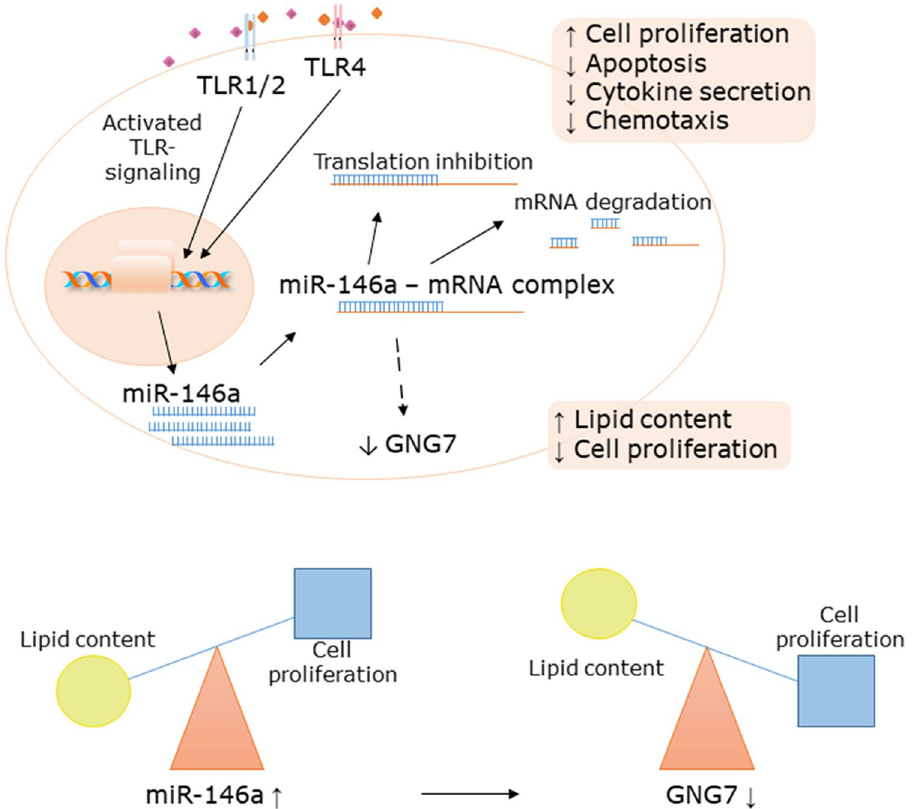
Figure 6. miR-146a links TLR-induced inflammation with cell proliferation and indirectly affects the lipid content of sebocytes via GNG7 . Our data showed that in response to TLR1/2 and -4 activation the expression of miR-146a, a microRNA leading to the degradation of its target mRNAs, is abundantly induced in sebocytes. The increased levels of miR-146a, observed also in acne samples, may have a negative regulatory effect on cytokine secretion and chemotaxis, induce cell proliferation and decrease apoptosis, while the parallel down-regulation of GNG7 , may shift the balance from proliferation to lipid accumulation. Figure was created with